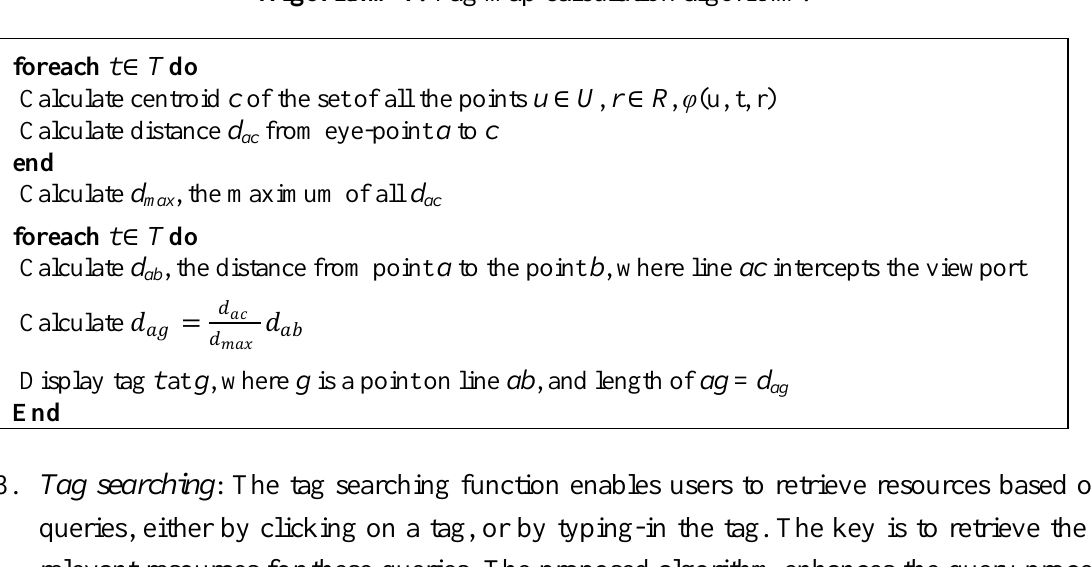
Algorithm 1. Tag map calculation algorithm.